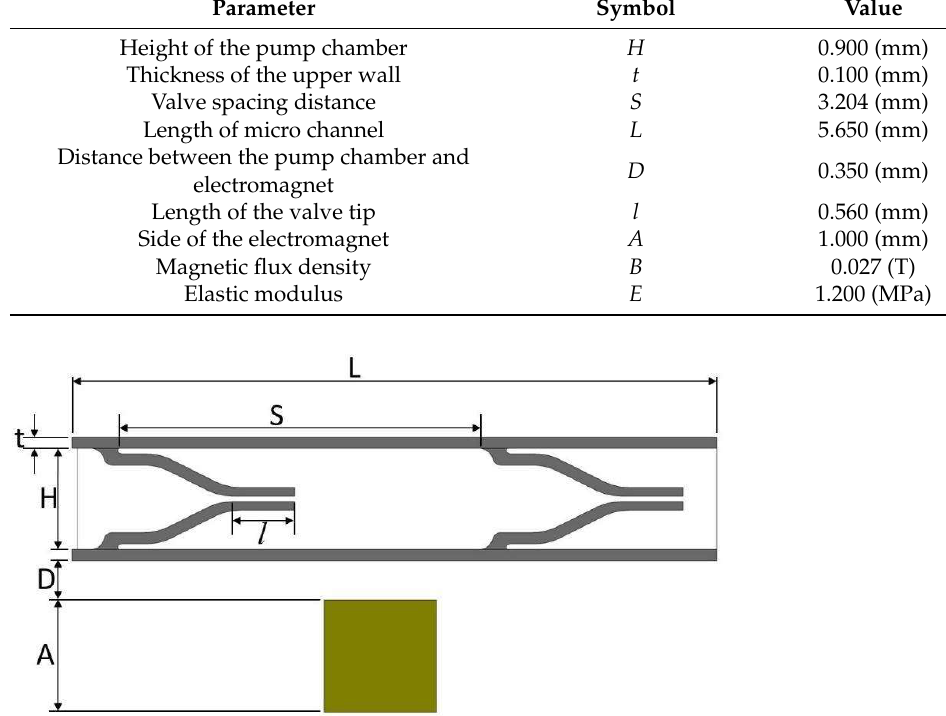
Figure 2. Duckbill valve model with its main components.